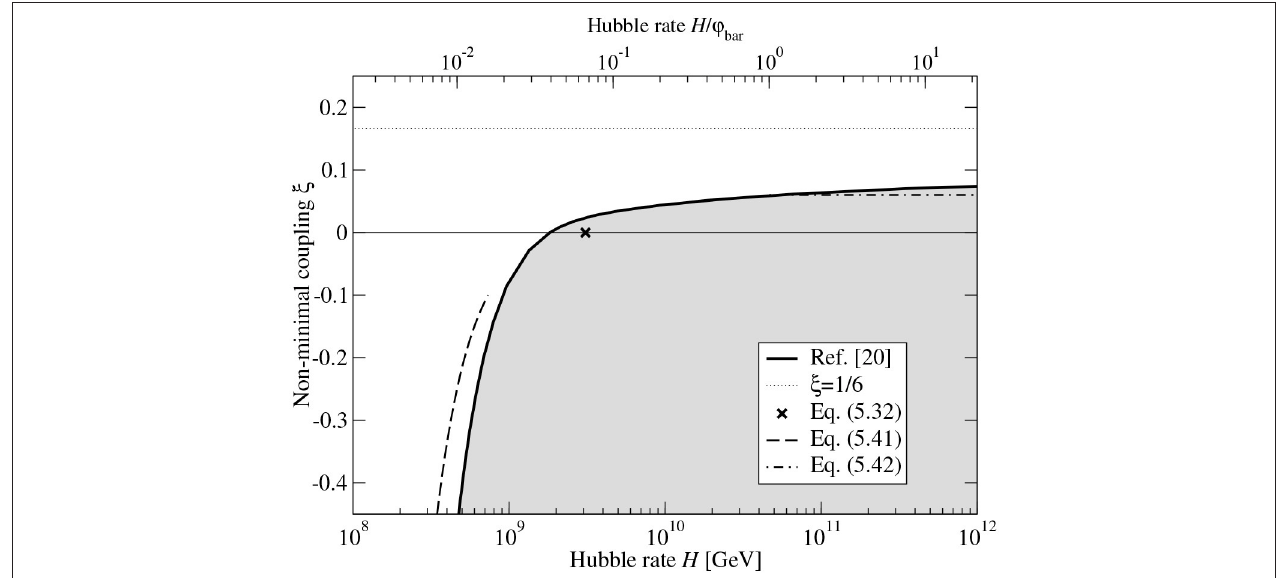
FIGURE 8 | Stability bounds on the non-minimal coupling ξ (renormalized at the electroweak scale) and the Hubble rate during inflation H inf . The colored area shows the unstable region based on the numerical results from Markkanen et al. (2018), the cross corresponds to Equation (5.32), the dashed line to Equation (5.41) and the dash-dotted line to Equation (5.42). The bottom axis refers to units calculated using the barrier position from Equation (2.32).